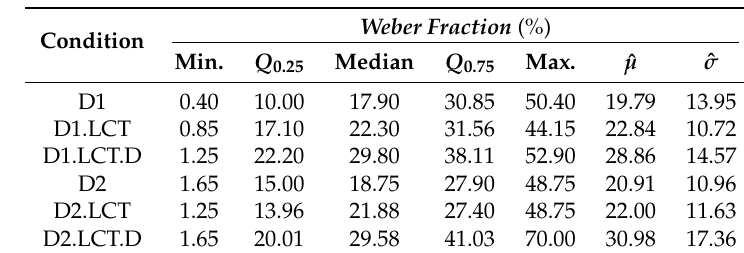
Table 3. Weber fractions for damping in different conditions with knob diameter (D1/D2), distraction (LCT/-), and detent (D/-). Values are given in Section6.1.